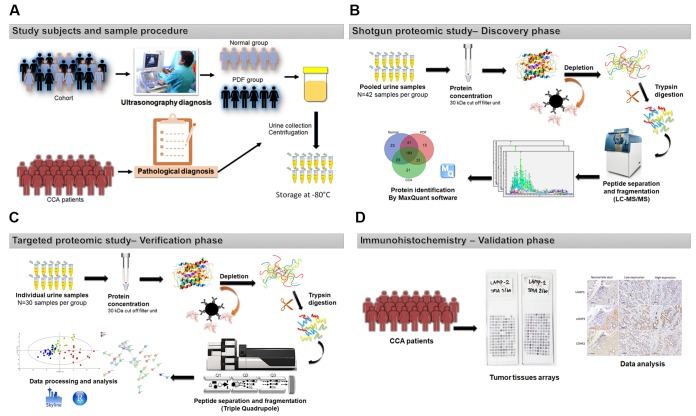
The workflow for urinary protein biomarker discovery.(A) urine samples were collected from participants and stored at -8000b0c until analysis. (B) urine samples selected for study were pooled, concentrated and depleted for highly-abundant protein removal using an immunodepletion kit, followed by in-solution tryptic digestion and tandem mass spectrometry. Protein identification and database searching were conducted using MaxQuant software (version 1.6.1.0). (C) Biomarker qualification for selected candidates used a custom MRM-MS assay. Data processing was performed using the Skyline and R programs. The statistical analysis software “SIMCA” and “SPSS" were used to perform the univariate/multivariate statistical analysis. (D) Immunohistochemical staining techniques were used to validate potential biomarkers on TMA.